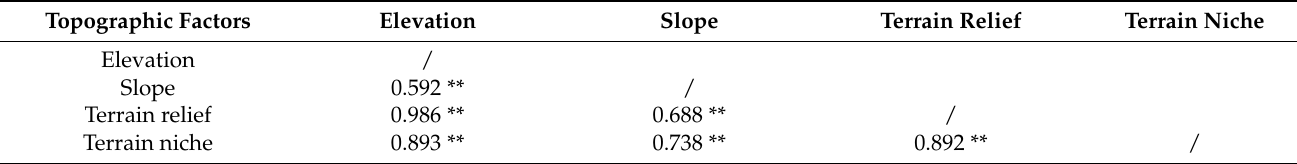
Table 8. The interrelationships between topographic